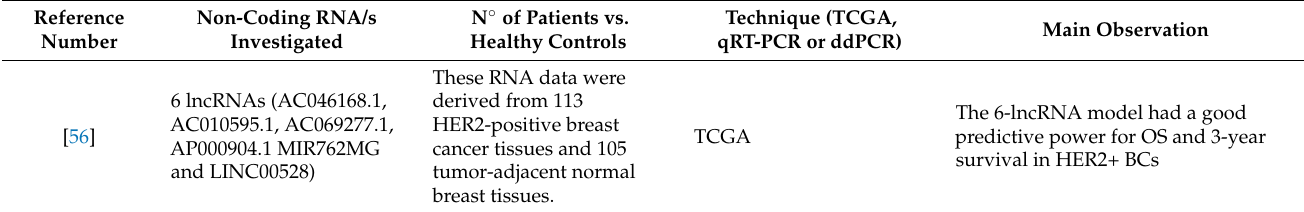
Figure 3. Biogenesis of lncRNA. LncRNA is either restricted to the nucleus, degraded, or exported from the nucleus into the cytoplasm. Outside the nucleus, lncRNA may localize to the mitochon- dria, other organelles, associate with ribosomes, or be secreted into the blood circulation with or without exosomes. Table 1. Non-coding RNA biomarkers for prediction of breast cancer prognosis. The clinical studies were searched on PubMed using the following words “biomarker non-coding RNA prognostic and diagnostic value in breast cancer”. We excluded animal studies, other reviews, and letters to the